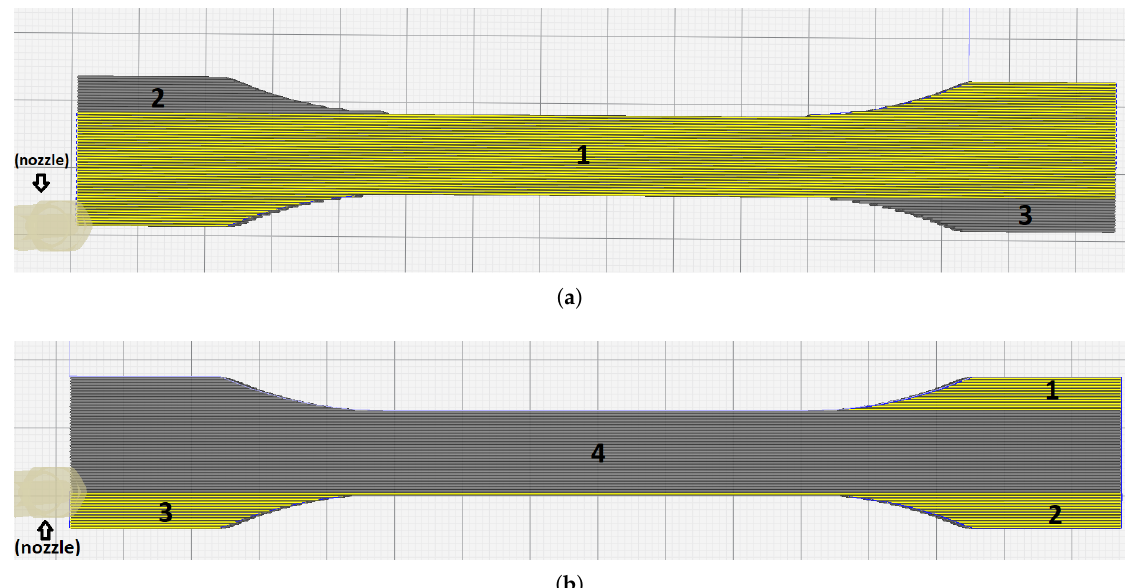
Figure 3. Simulation by using two different slicing approaches. ( a ) Newly optimized Slicing A and ( b ) Current Slicing B.